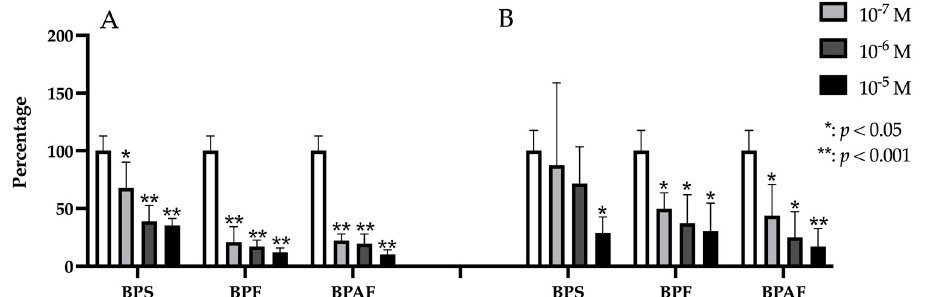
Figure 2. Expression of BMP2 ( A ) and BMP7 ( B ) in primary human osteoblasts treated for 24 h with bisphenol S, F, and AF (10 − 7 , 10 − 6 , or 10 − 5 M). The assay was performed in triplicate with each of the three primary human osteoblast cell lines. Data are expressed as percentage expression with respect to control ± standard deviation. Significant differences * p < 0.05; ** p < 0.001.